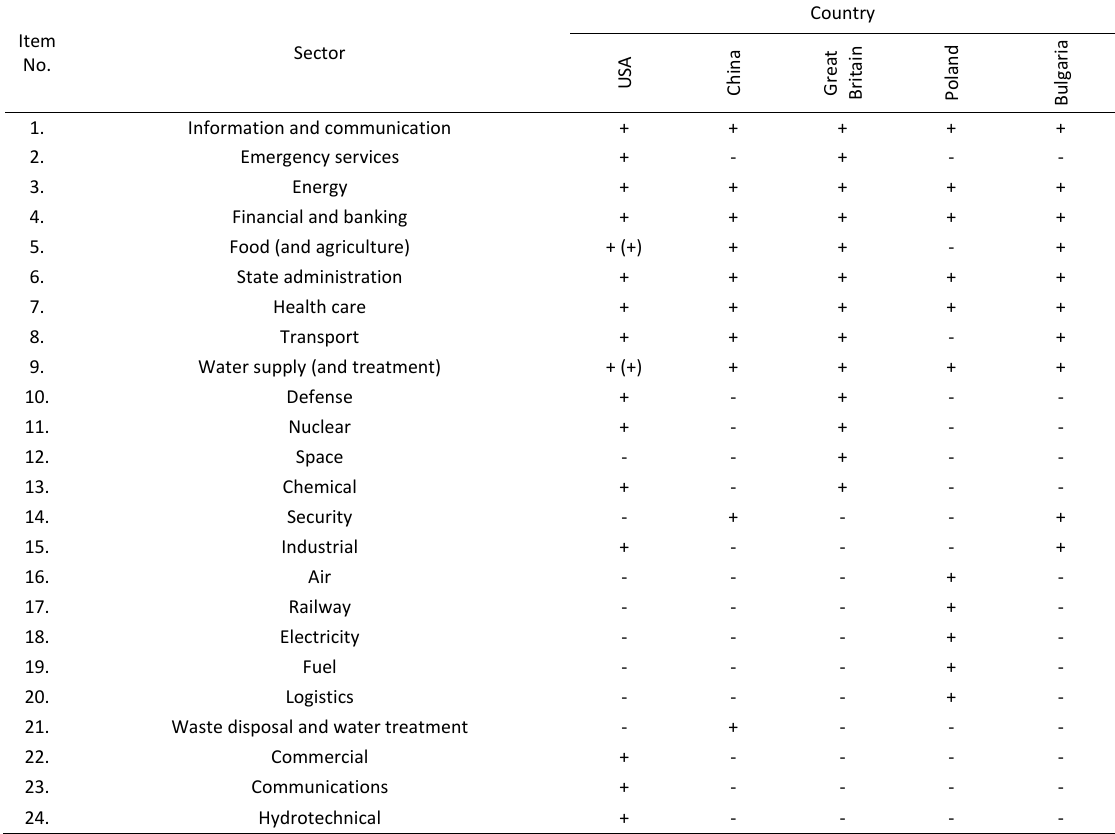
Table 1: Critical infrastructure sectors of some countries